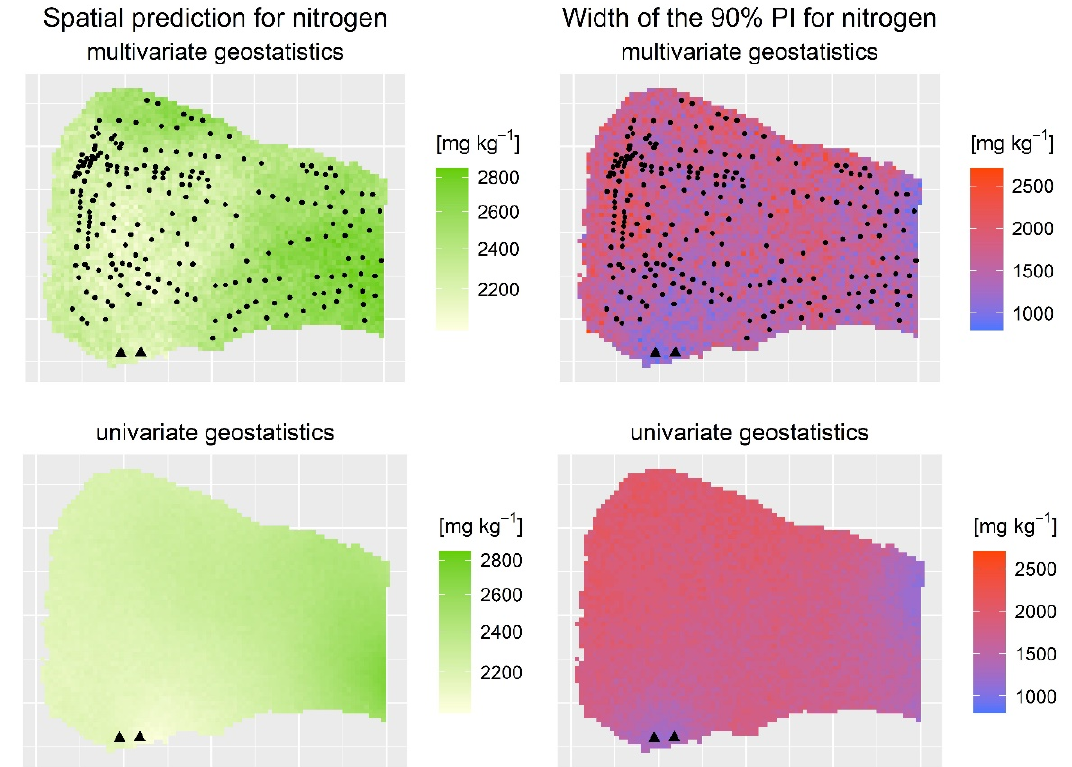
Figure 6. Point-support predictions for the nutrient nitrogen ( first column ) and the associated prediction uncertainty ( last column ) in the Keszthely basin given by multivariate ( first row ) and univariate geostatistics ( last row ). Annotation: black dots represent sampling points where only phosphorus data are available, whereas black triangles mean sampling points where data on both nutrients are available. Abbreviation: PI: prediction interval. Table 3. Validation of nitrogen, phosphorus, and nitrogen-to-phosphorus ratio spatial predictions